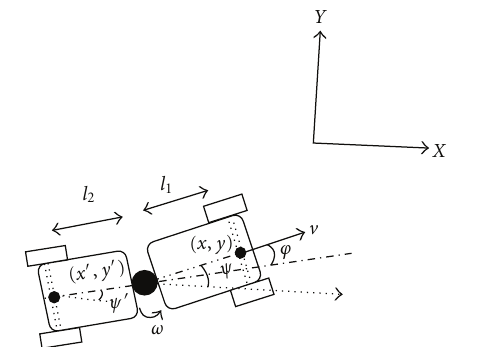
Figure 3: Derivation of nonholonomic